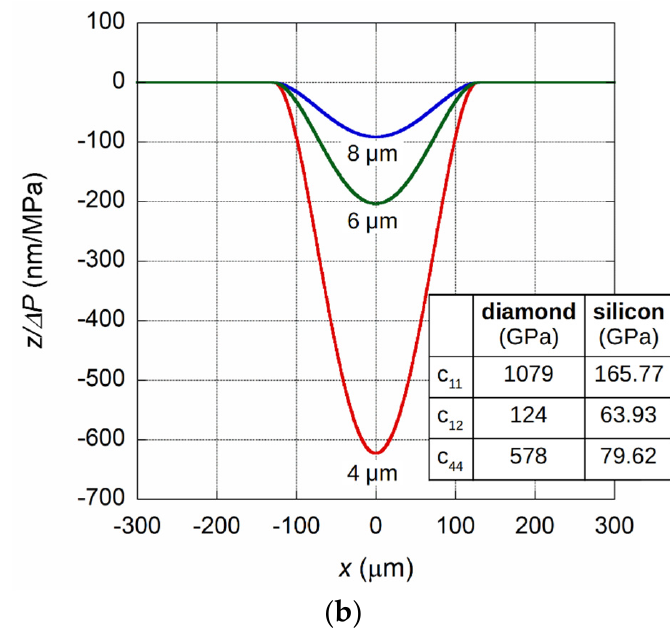
Figure 3. ( a ) Schematic of suspended diamond on a silicon diaphragm under the applied differential pressure. ( b ) Numerical calculation of the diamond membrane deflection normalized to inlet pressure for 4, 6, and 8 μ m thick membranes with a diameter of 250 μ m. Inset: elastic constants c ij for the crystalline diamond and silicon.